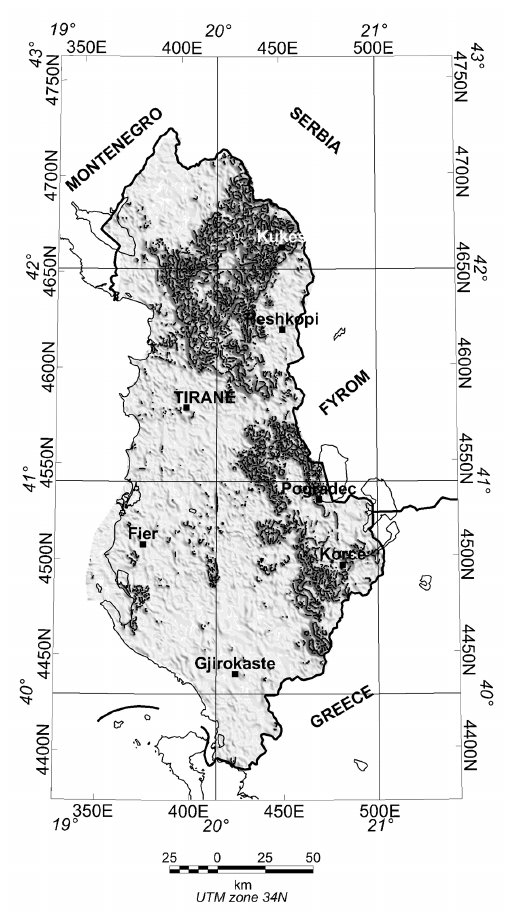
Fig. 10. The second horizontal derivative of the mag- netic anomaly of Albania. The derivative is calculated after reducing the anomaly to the north magnetic pole. The maxima of the gradient are denoted by black